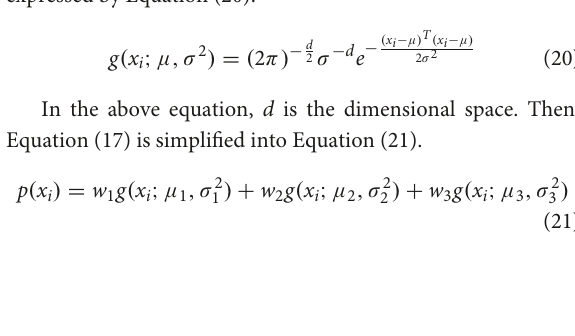
σ 2 I represents the covariance, where I represents the j multidimensional identity matrix, and the covariance equation is shown in Equation